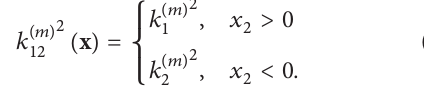
(𝑚) ( x ) is the wave-number of the two-layered media In (12), 𝑘 12 with a planar interface and its square is given